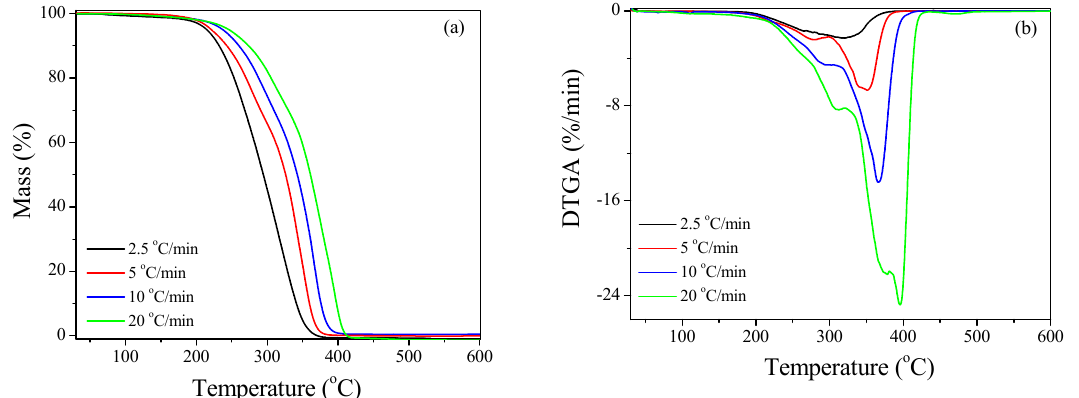
Figure 2. The heating rate efficacy on the thermogravimetric analysis (TGA) scans ( a ) and differential TGA (DTGA) curves ( b ) of neat PMMA.